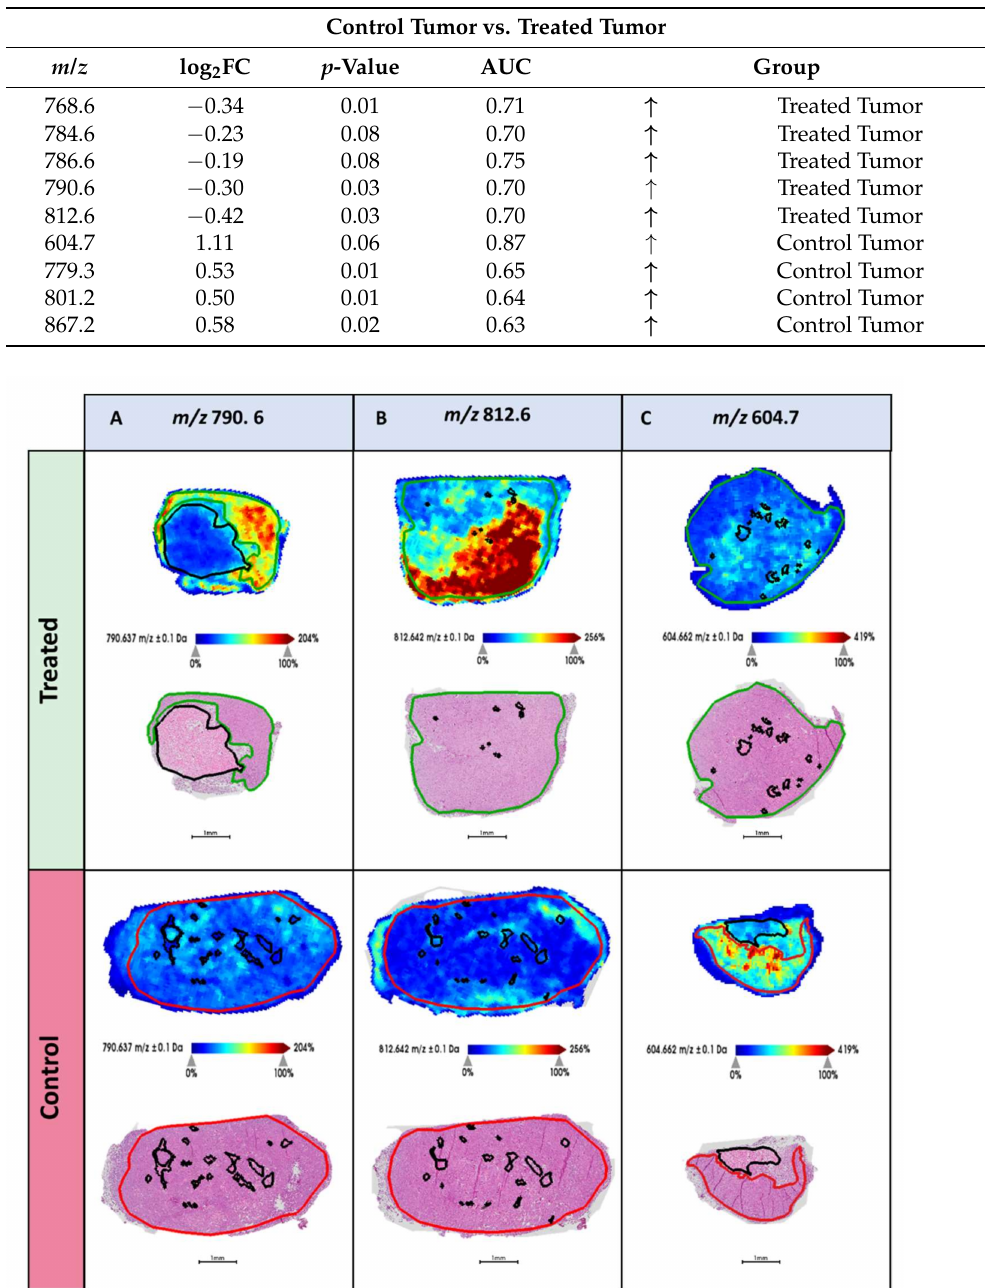
Table 3. Summary of the fold change (log 2 FC), p -value determined by the Wilcoxon Rank Sum Test, the principal component (PC) loading scores, and AUC values when comparing tumors of the treated and control xenografts.